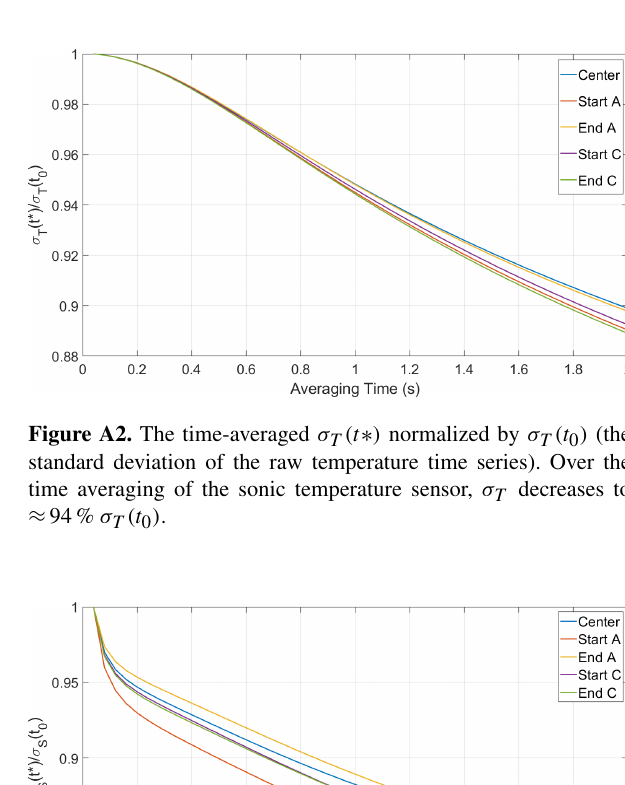
Figure A1. The spectra of the temperature measurement for several different pathlengths. These spectra are averaged along line B and are smoothed for clarity. The dashed line is a power law ( f − 5 / 3 ) included as a reference.